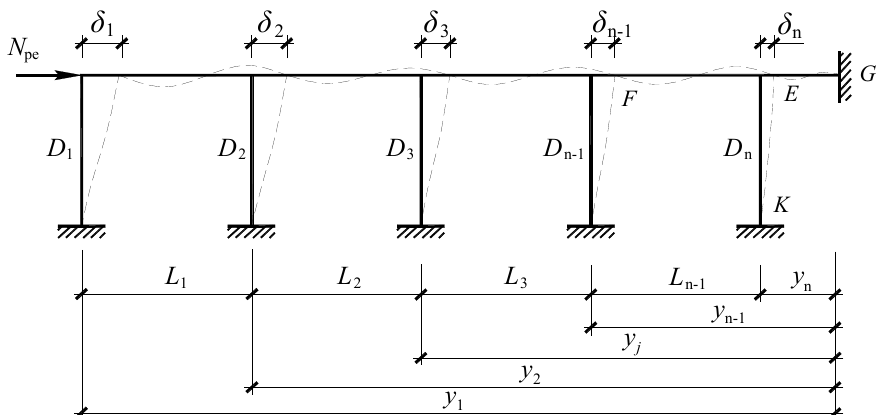
Figure 1. Structural-analysis sketch.